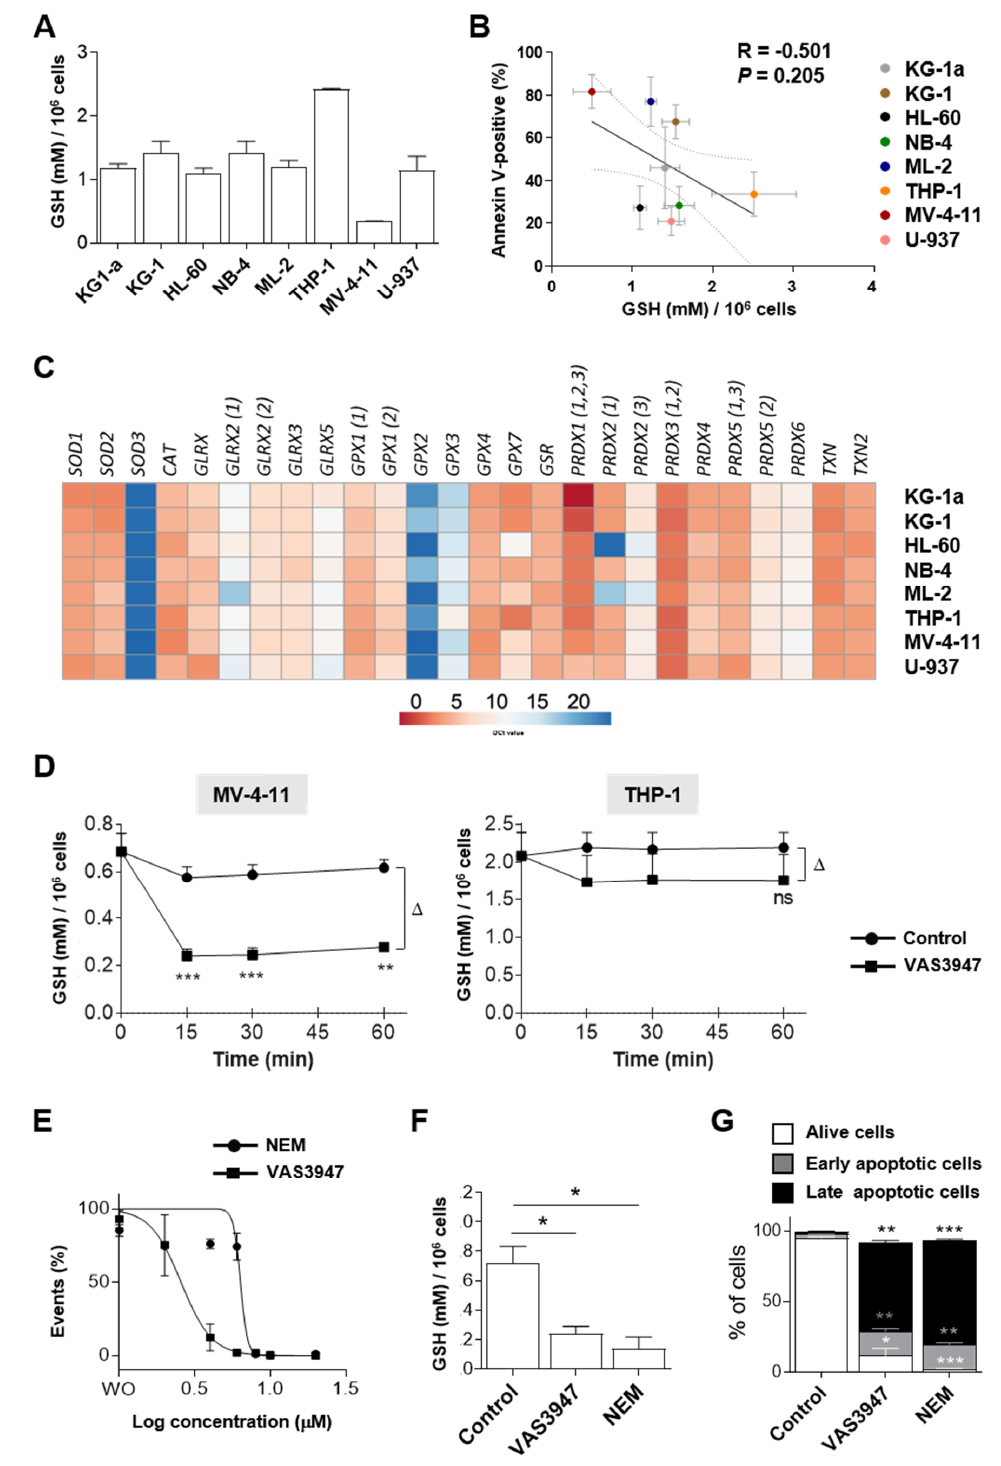
Figure 5. Evaluation of physiological glutathione (GSH) and the effect of 4 µM VAS3947 on AML cell lines. ( A ) Levels of GSH in eight AML cell lines. GSH levels were detected based on Tietze’s method. Data are shown as mean ± SEM of n = 3 independent experiments. ( B ) Correlation between GSH levels